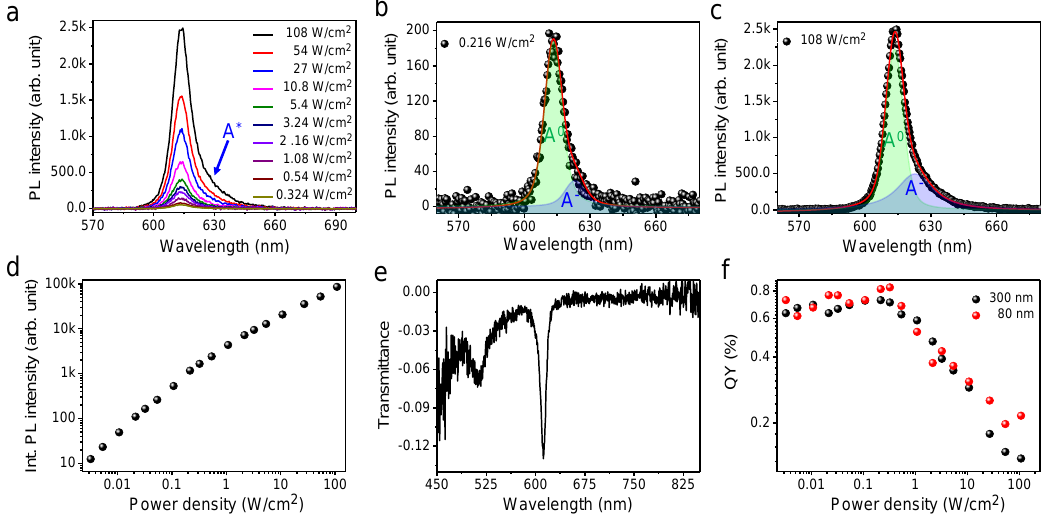
Figure 2. ( a ) Confocal PL spectra of the exfoliated 1L-WS 2 on a quartz substrate with various laser intensities. Deconvoluted PL spectra of the exfoliated 1L-WS 2 at ( b ) 0.216 W/cm 2 and ( c ) 108 W/cm 2 . ( d ) Integrated PL intensity of 1L-WS 2 as a function of laser intensity. ( e ) Representative transmittance spectrum of 1L-WS 2 . ( f ) Plot of the QYs of 1L-WS 2 as a function of laser intensity, estimated using 80- and 300-nm-thick reference